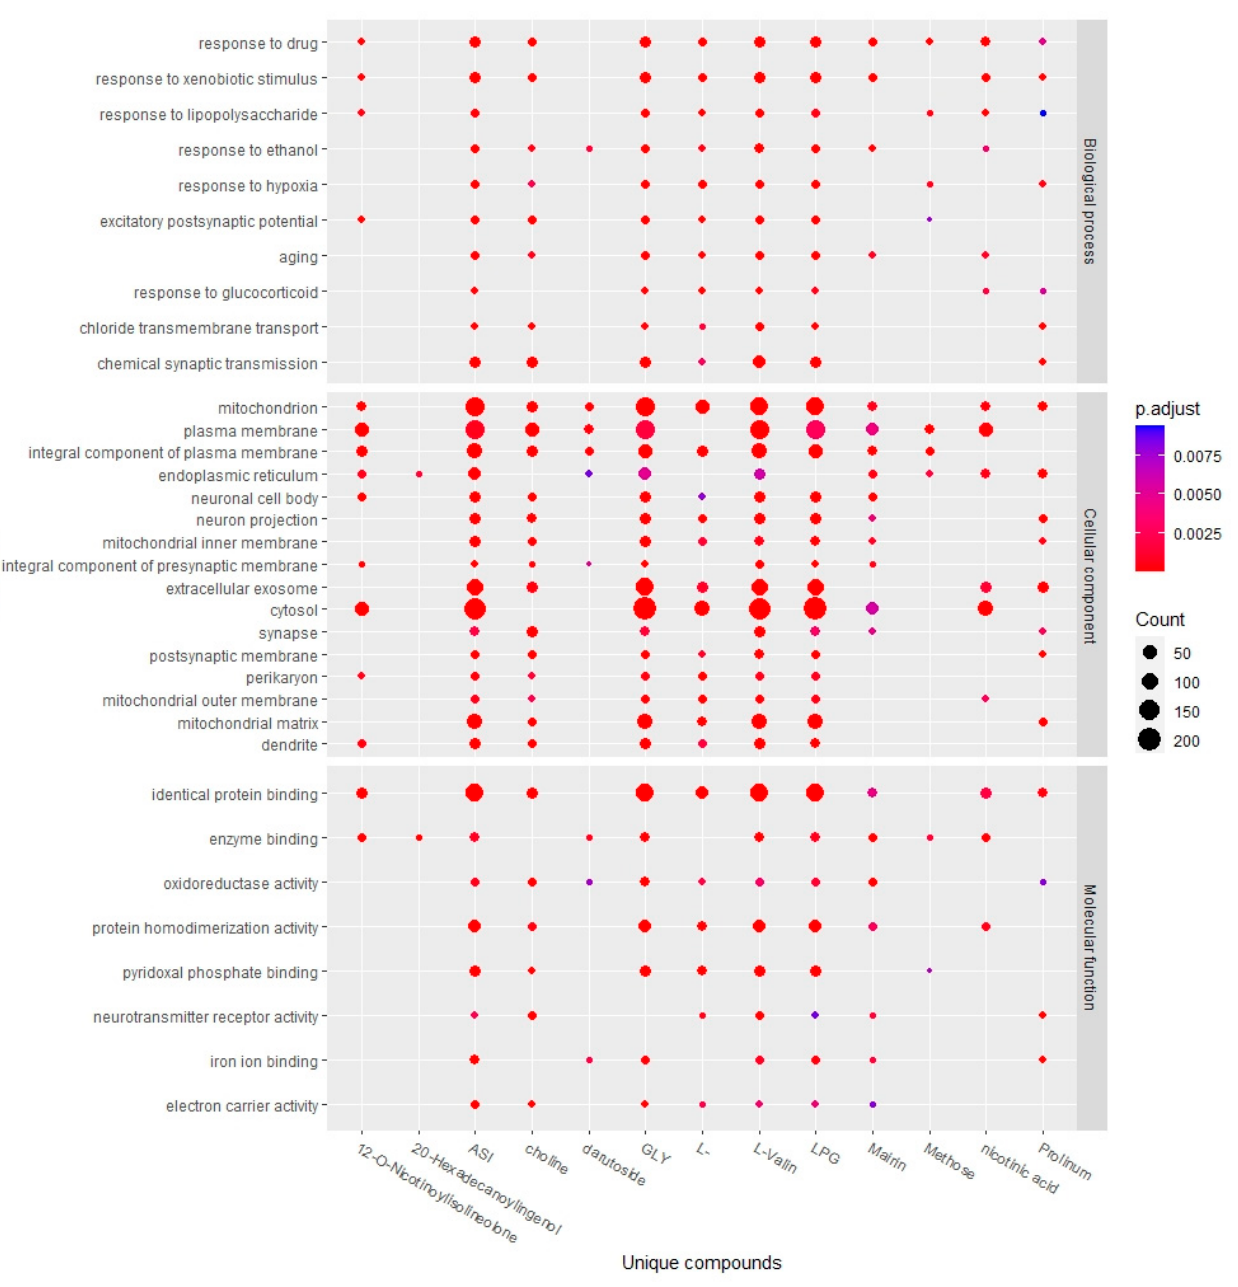
Figure 3. Top main KEGG pathways of unique compounds of Qi-invigorating herbs. LPG, L-ala- nine; GLY, glycine; ASI, aspartic acid; L-, L-arginine.